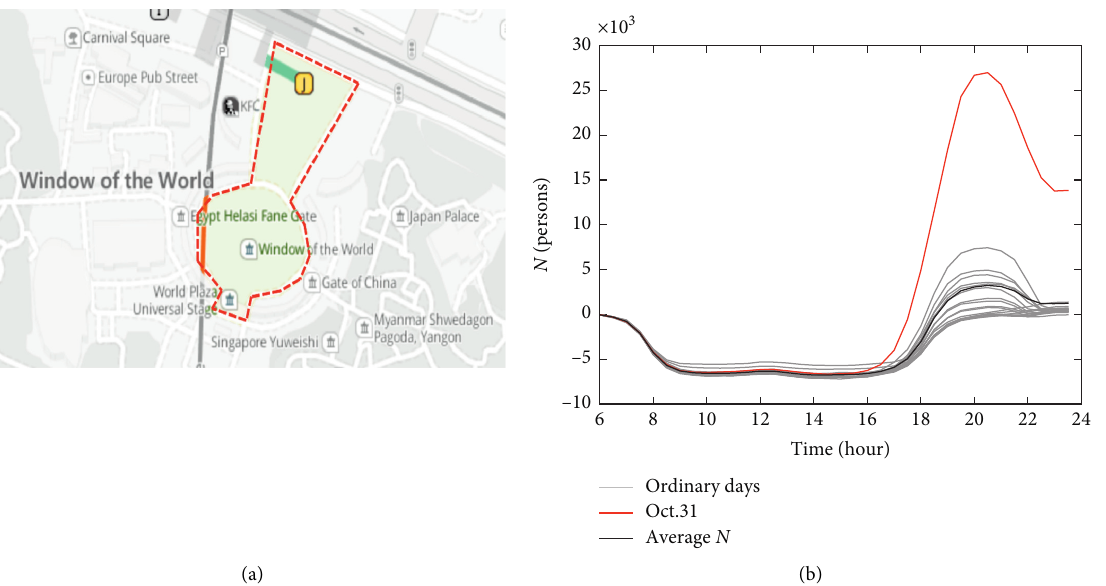
Figure 3: (a) The crowd gathering area of the Halloween event. (b) Estimated number of passengers gathered at the plaza of the Window of the World.